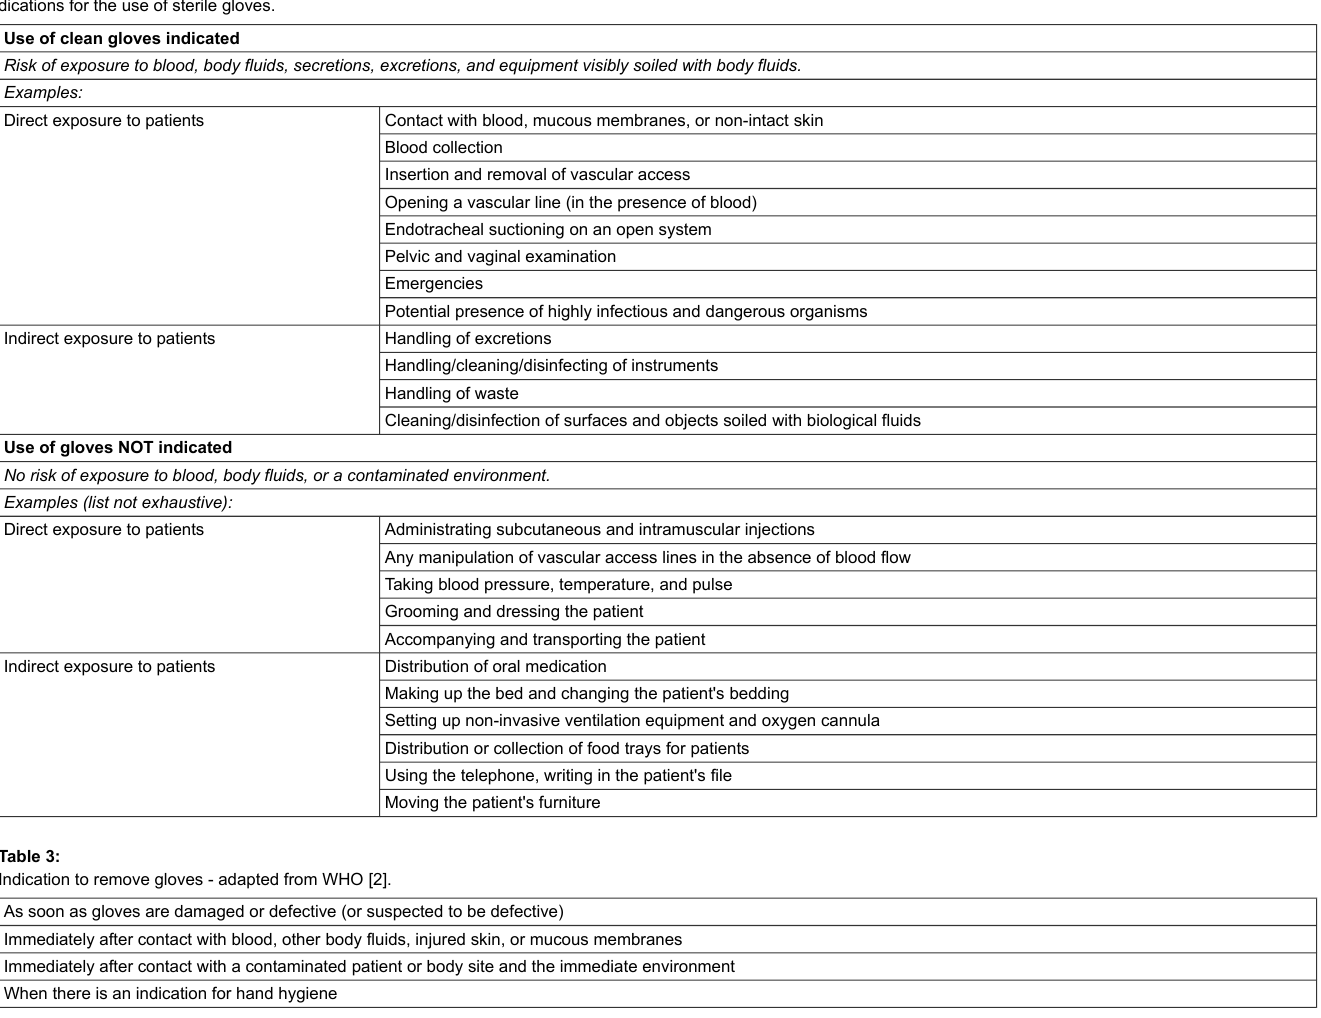
Table 2: Clinical indications for the use of gloves according to standard precautions (independently of isolation precautions) adapted from WHO [2]. Of note: this table does not cover in- dications for the use of sterile gloves. Use of clean gloves indicated Risk of exposure to blood, body fluids, secretions, excretions, and equipment visibly soiled with body fluids.